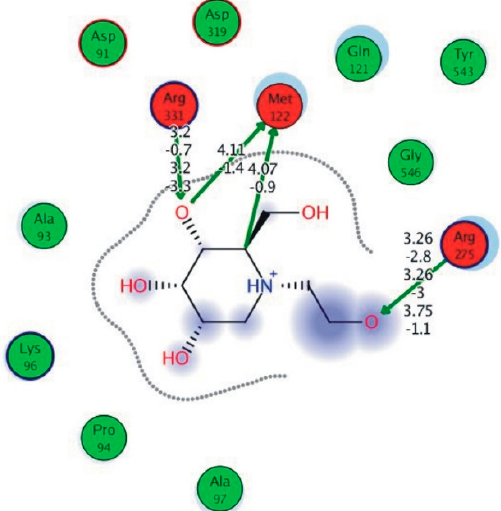
Gln121, Met122, Arg275, Pro545, and one arene-cation interaction with Trp126 of the target protein.